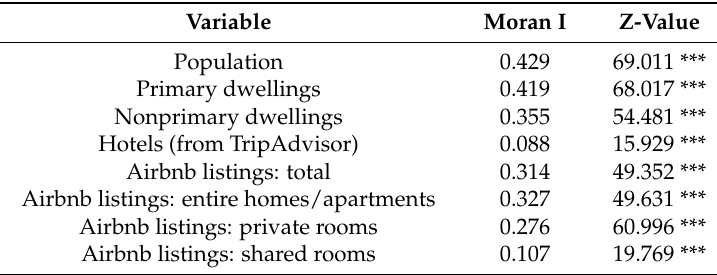
Table 4. Values of univariate global Moran